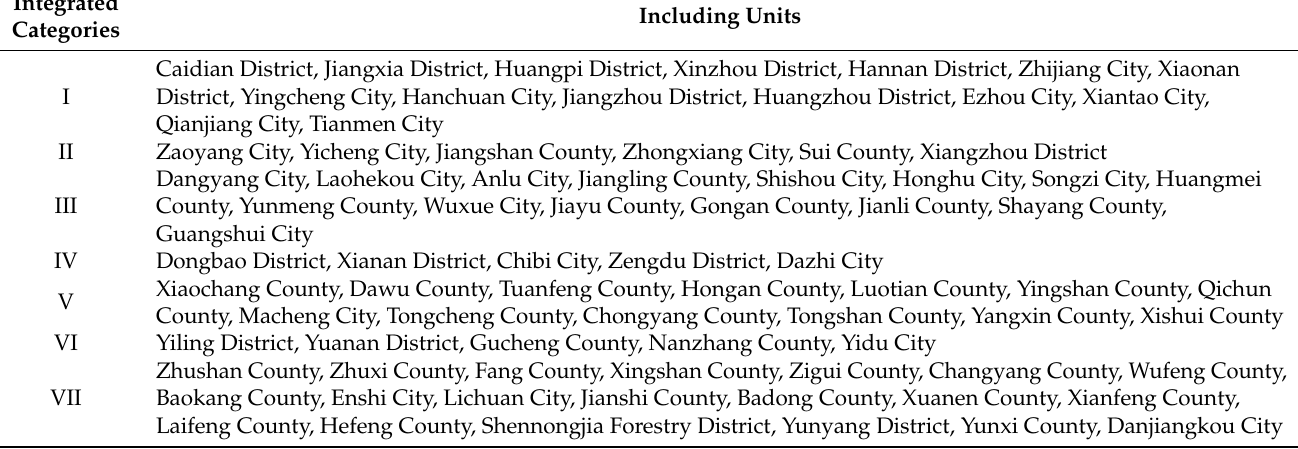
Table 5. Land consolidation zoning scheme for Hubei